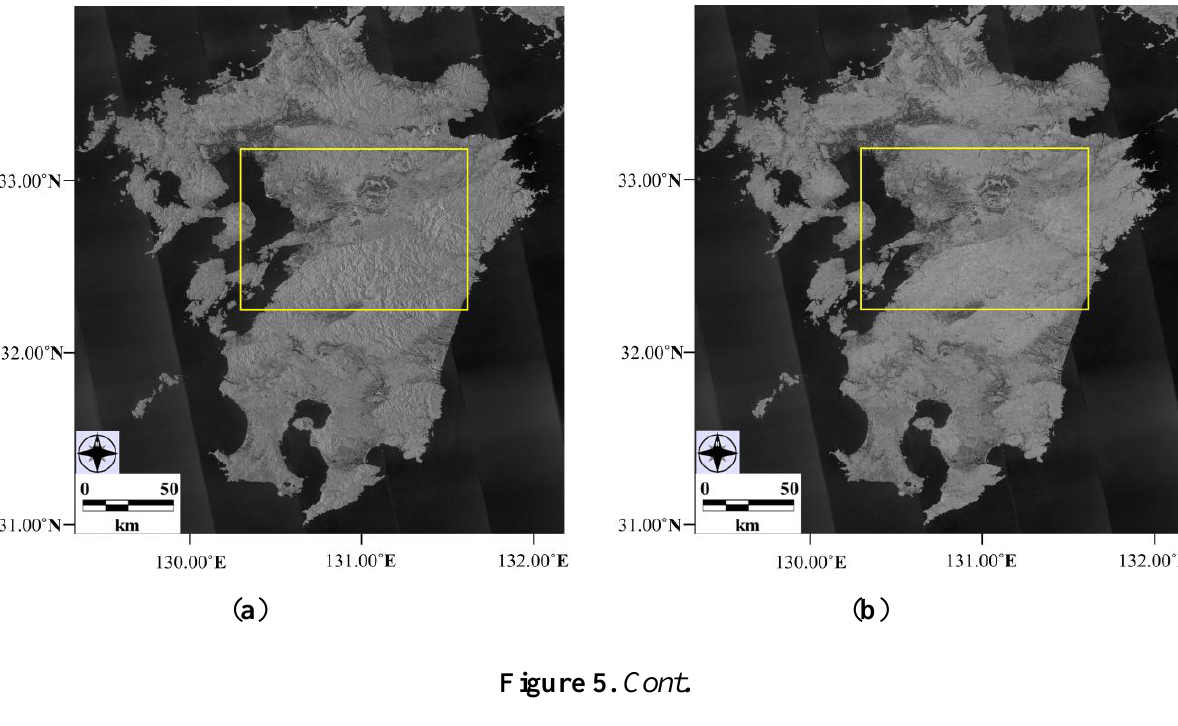
Figure 4. Validation of the backscattering model. The X-axis is the estimated volume (m 3 /ha) using the model, and the Y-axis is the reference data from the observation plot. R 2 = 0.164 Root Mean Square Error (RMSE) = 105.58 m 3